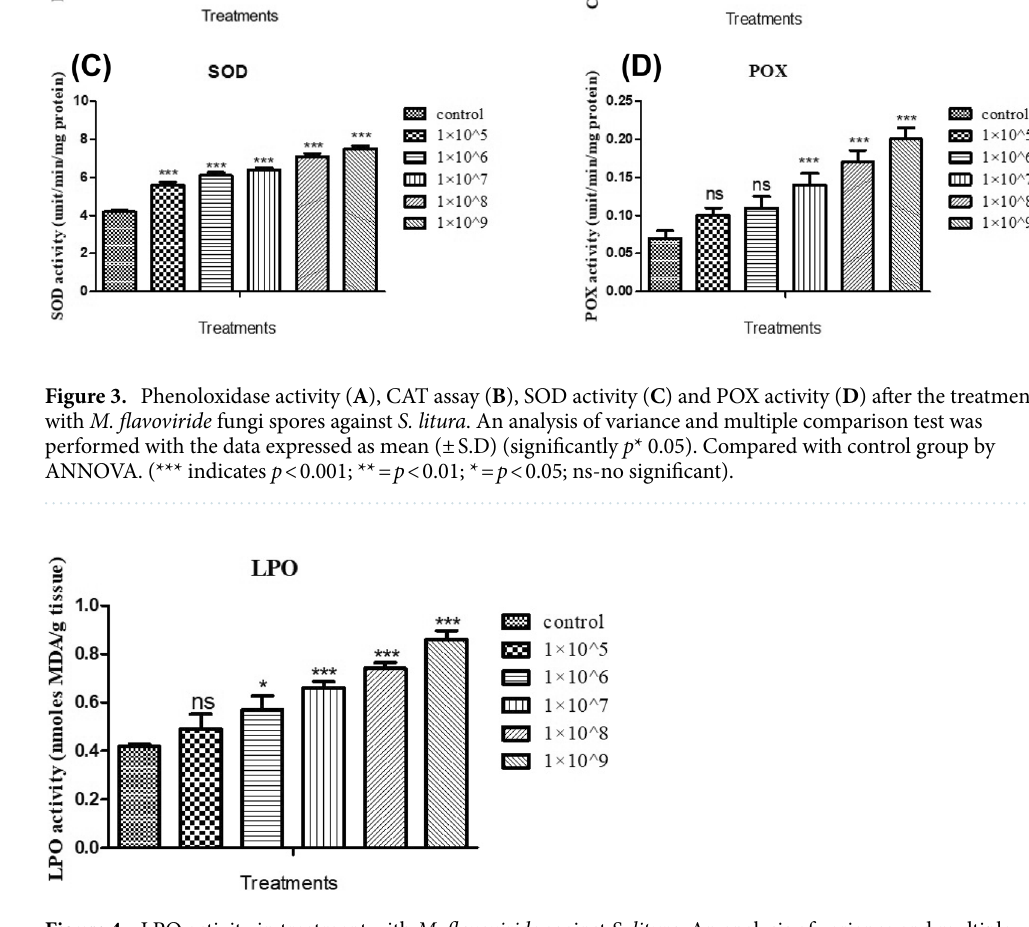
Figure 4. LPO activity in treatment with M. flavoviride against S. litura . An analysis of variance and multiple comparison test was performed with the data expressed as mean (± S.D) (significantly p* 0.05). Compared with control group by ANNOVA. (*** indicates p < 0.001; ** = p < 0.01; * = p < 0.05; ns-no